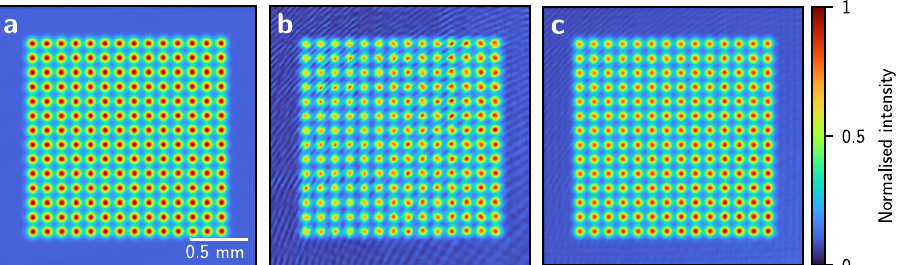
Figure 2. Simulated and experimental images illustrating the effect of pixel crosstalk. ( a ) Simulated light potential for a spot array target light potential. ( b ) Camera image of the experimental light potential showing fringes and an intensity gradient, with less intense spots in the top left of the image. ( c ) Simulated light potential after up-scaling and convolving the SLM phase pattern with kernel K . The fringes and the intensity gradient seen in the camera image ( b ) are reproduced in the simulation, however, with reduced contrast.